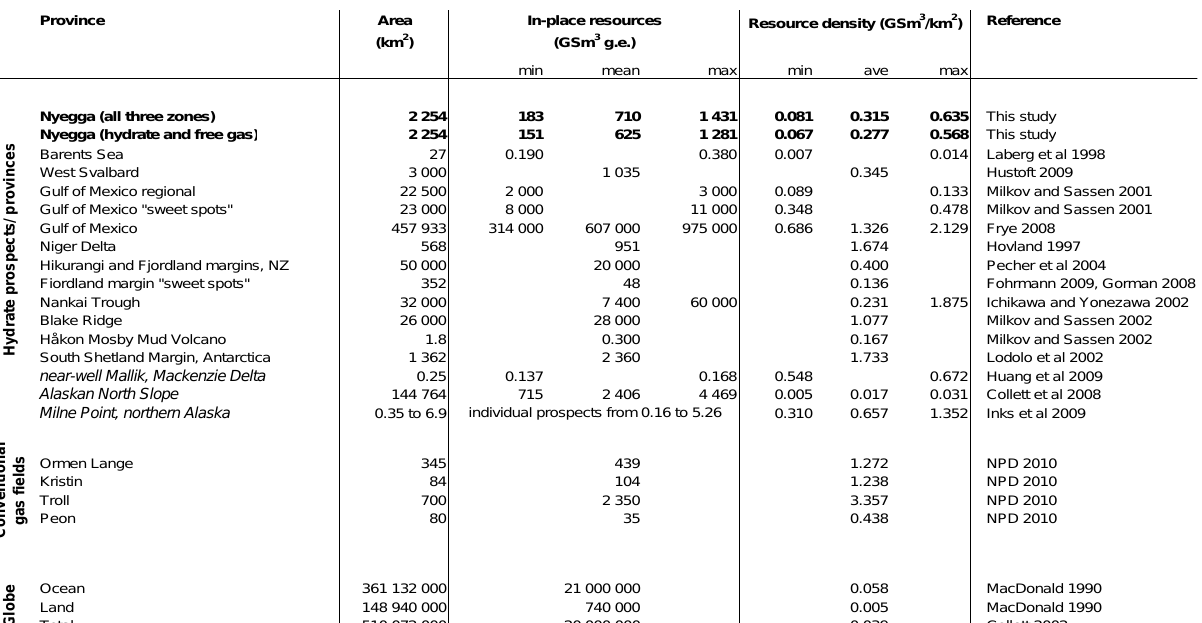
Table 4. Comparison of the resource density at the Nyegga prospect and other hydrate and conventional deposits worldwide. Note that permafrost hydrate provinces are denoted with italics. Data from this study, Collett et al. [25], Collett [26], Ichikawa and